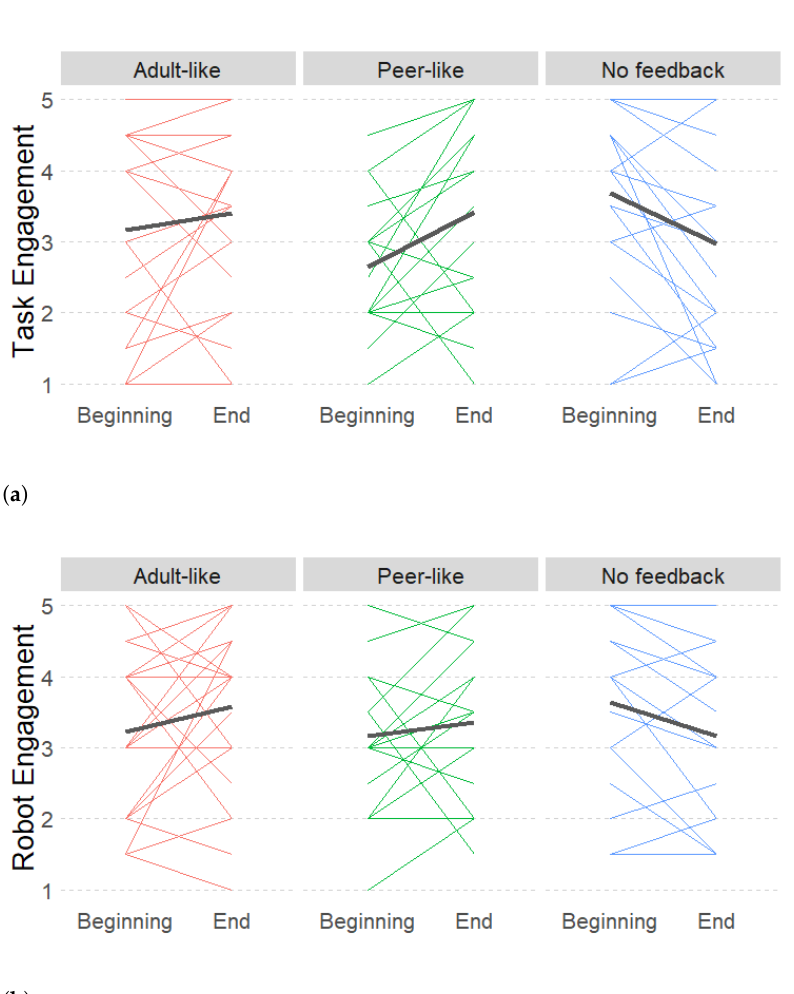
Figure 2. The individual children’s ( a ) task engagement scores and ( b ) robot engagement scores over the three conditions in the beginning and end of the tutoring lesson. The dark lines show the averages of the children’s engagement